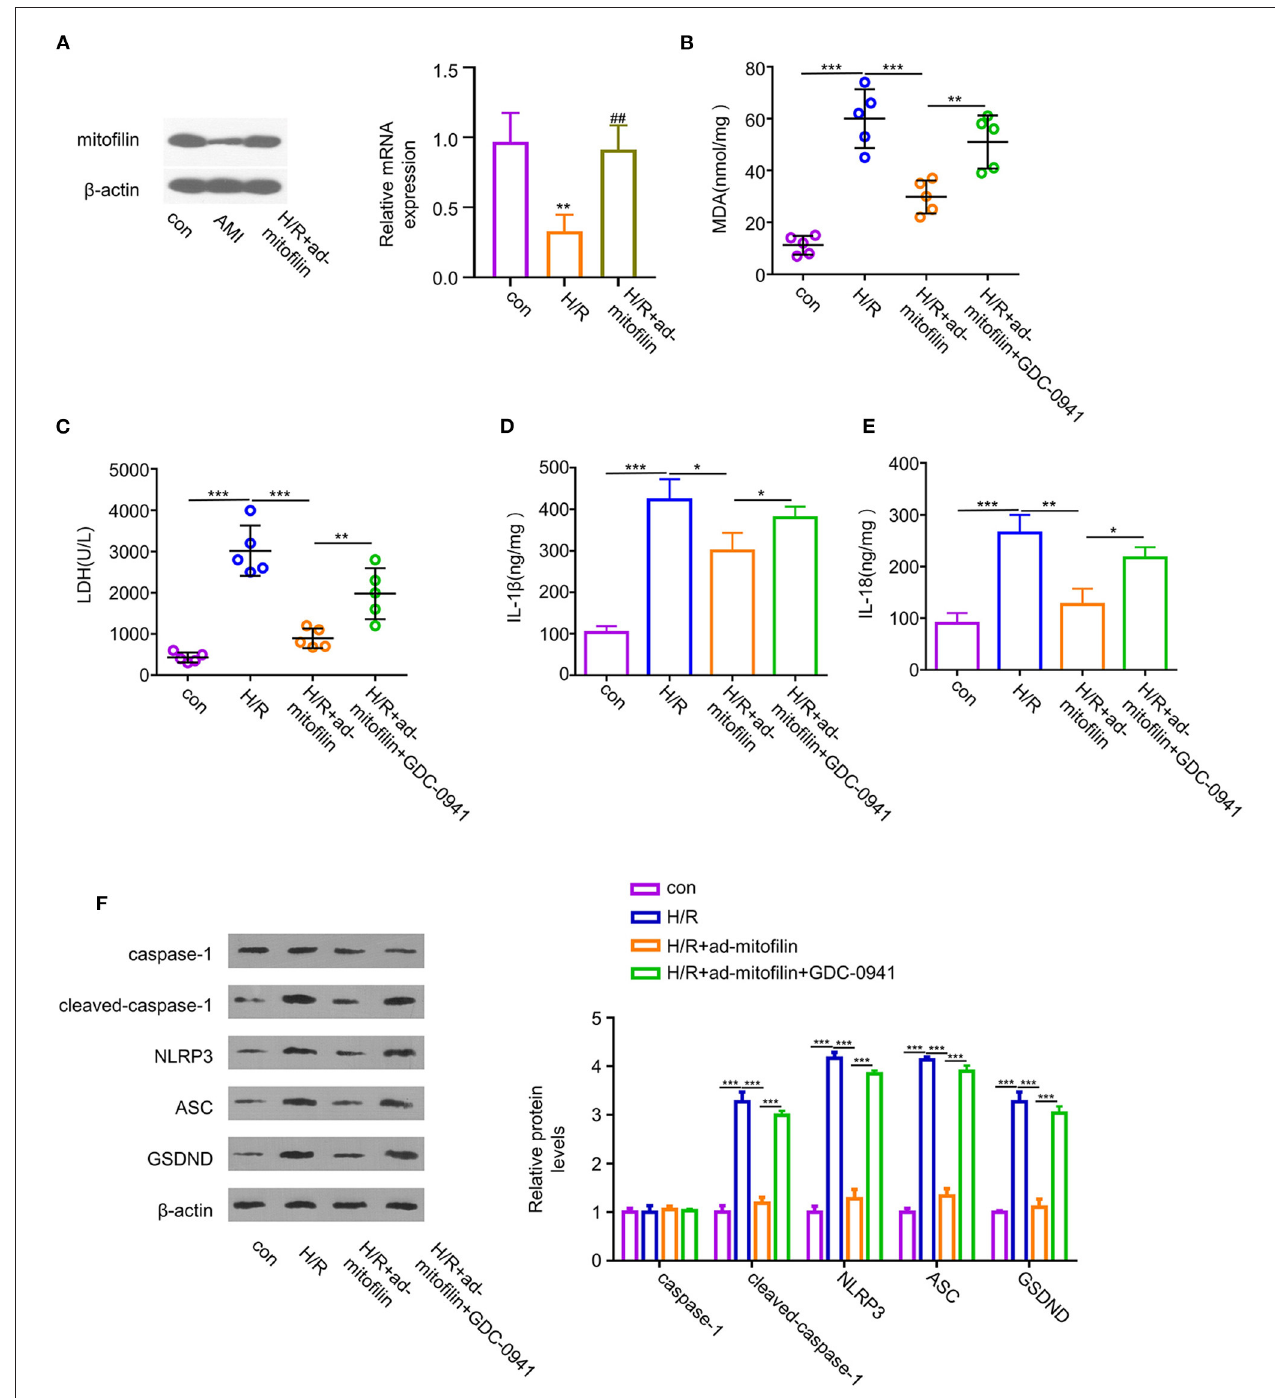
FIGURE 5 | The protective effect of mitofilin in the H/R-induced H9C2 damage is dependent on PI3K activity. (A) Hypoxia/reoxygenation induced a decrease in the mitofilin expression level in H9C2 cells. The level of mitofilin protein was increased after mitofilin overexpression. (B,C) Hypoxia/reoxygenation induced increase of the MDA level and LDH level was partially reduced after mitofilin overexpression. The presence of GDC-0941 (a PI3K inhibitor) abrogated the rescue effect. (D,E) Hypoxia/reoxygenation induced the increase of IL-1 β and IL-18 levels in H9C2 cells, and mitofilin overexpression reduced their levels. The presence of GDC-0941 abrogated the rescue effect. (F) Mitofilin overexpression suppressed the protein levels of cleaved-caspase-1, NLRP3, ASC, and GSDND in H9C2 cells upon H/R induction, and the effects were abrogated by GDC-0941. * P < 0.05, ** P < 0.01, and *** P < 0.001. ##: H/R vs H/R + ad-mitofilin: P < 0.01.